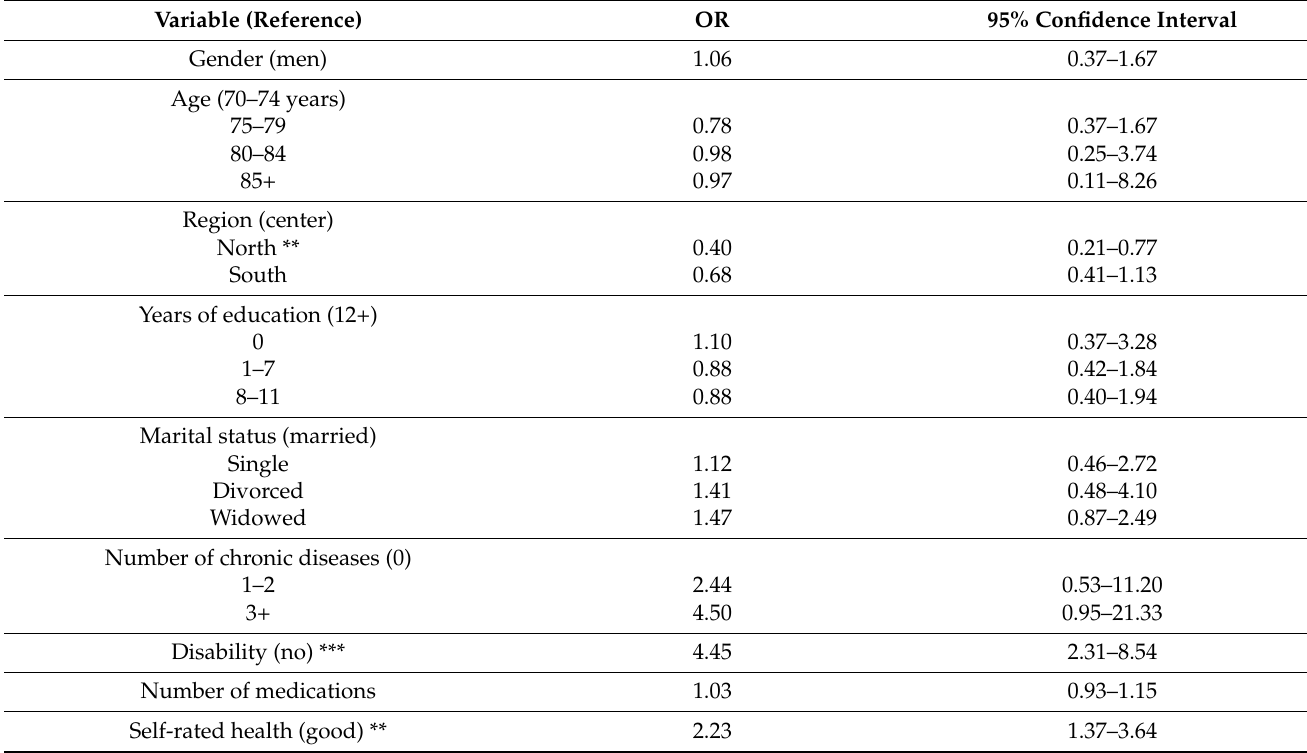
Table 2. Adjusted odds ratio of positive screen for